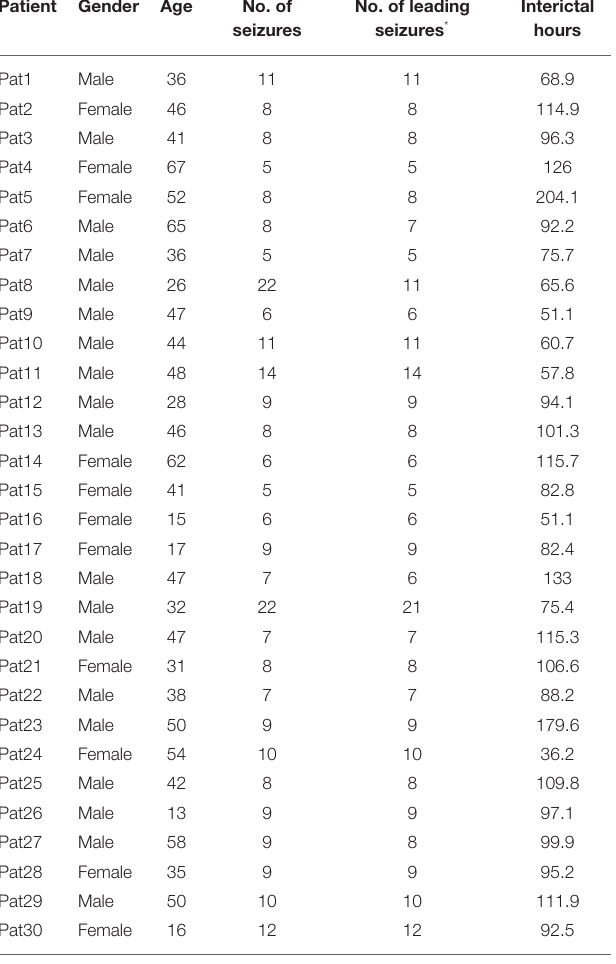
TABLE 1 | The EPILEPSIAE scalp-EEG